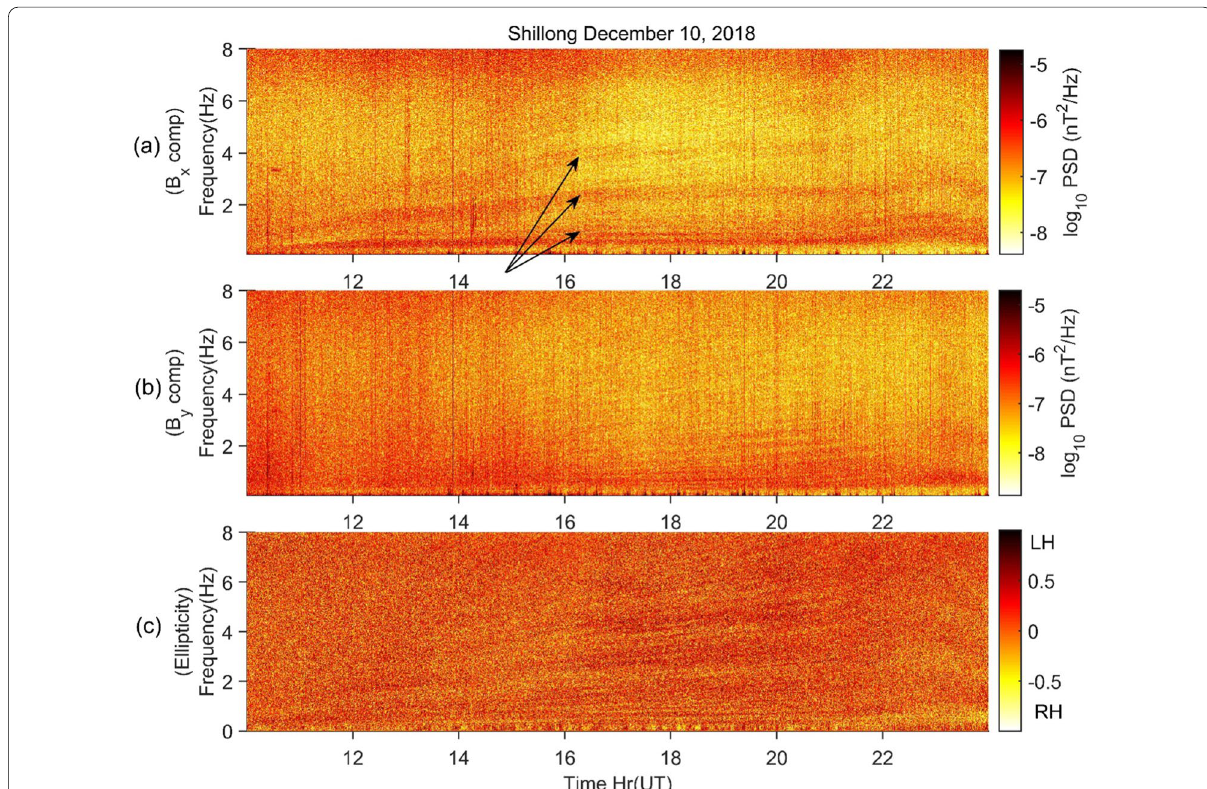
Fig. 4 Dynamic spectra of B x ( a ), B y ( b ) components and ellipticity ( c ), respectively, demonstrating the presence of double spectral resonance structures IAR observed at Shillong on December 10,